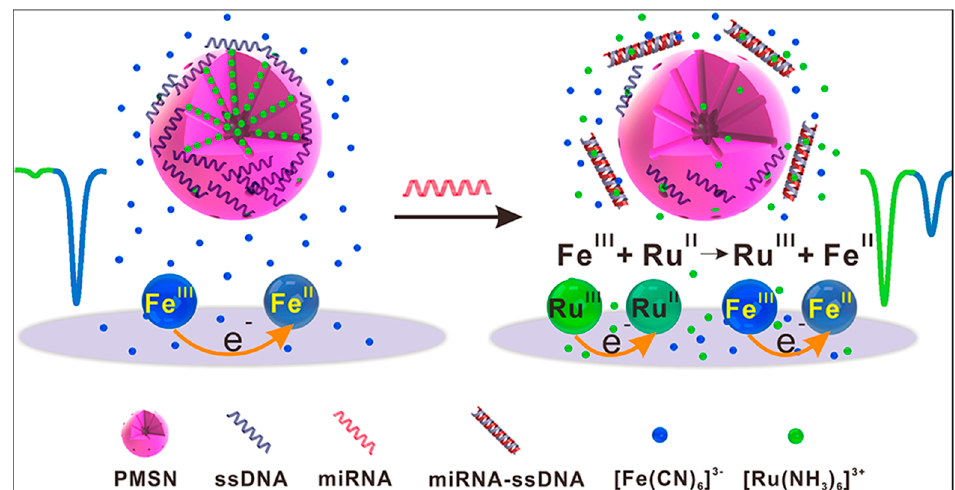
Figure 16. Scheme presenting the use of two free RedOx indicators reprinted from [180] with permission from ( Anal. Chem. 2017 , 89 , 12293--11298). Copyright (2017) American Chemical Society.